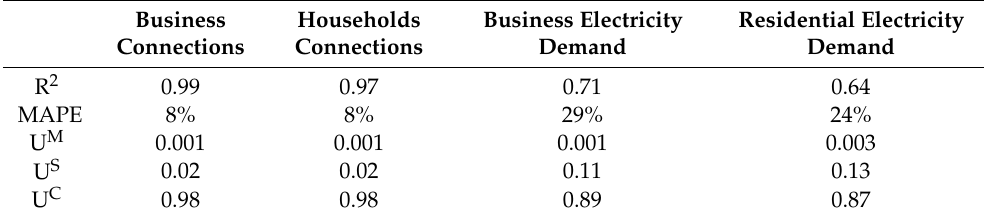
Figure 2. Comparison between historical data against model simulations. Connections and electricity consumption values are selected, differentiating between productive use (businesses) and household (residential) demand. Table 2. Model quality metrics applied to the number of connections and the amount of consumed electricity for both businesses and